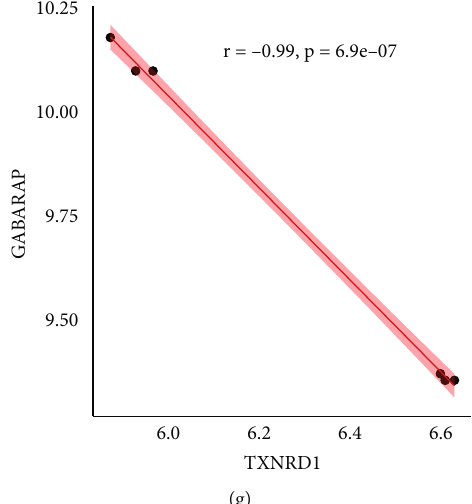
Figure 6: Correlation analysis between oxidative stress and autophagy in degenerative NPCs. (a) Comparison of autophagy score between NPC/MSC samples and NPC samples; (b) Correlation analysis between oxidative stress score and autophagy score; (c) Venn diagram to obtain the autophagy-related DEGs; (d) Heat map of autophagy-related DEGs; (e) Correlation analysis between top 10 hub OSRDEGs and 13 autophagy-related DEGs; (f) Correlation analysis between GABARAP and CAT; (g) Correlation analysis between GABARAP and